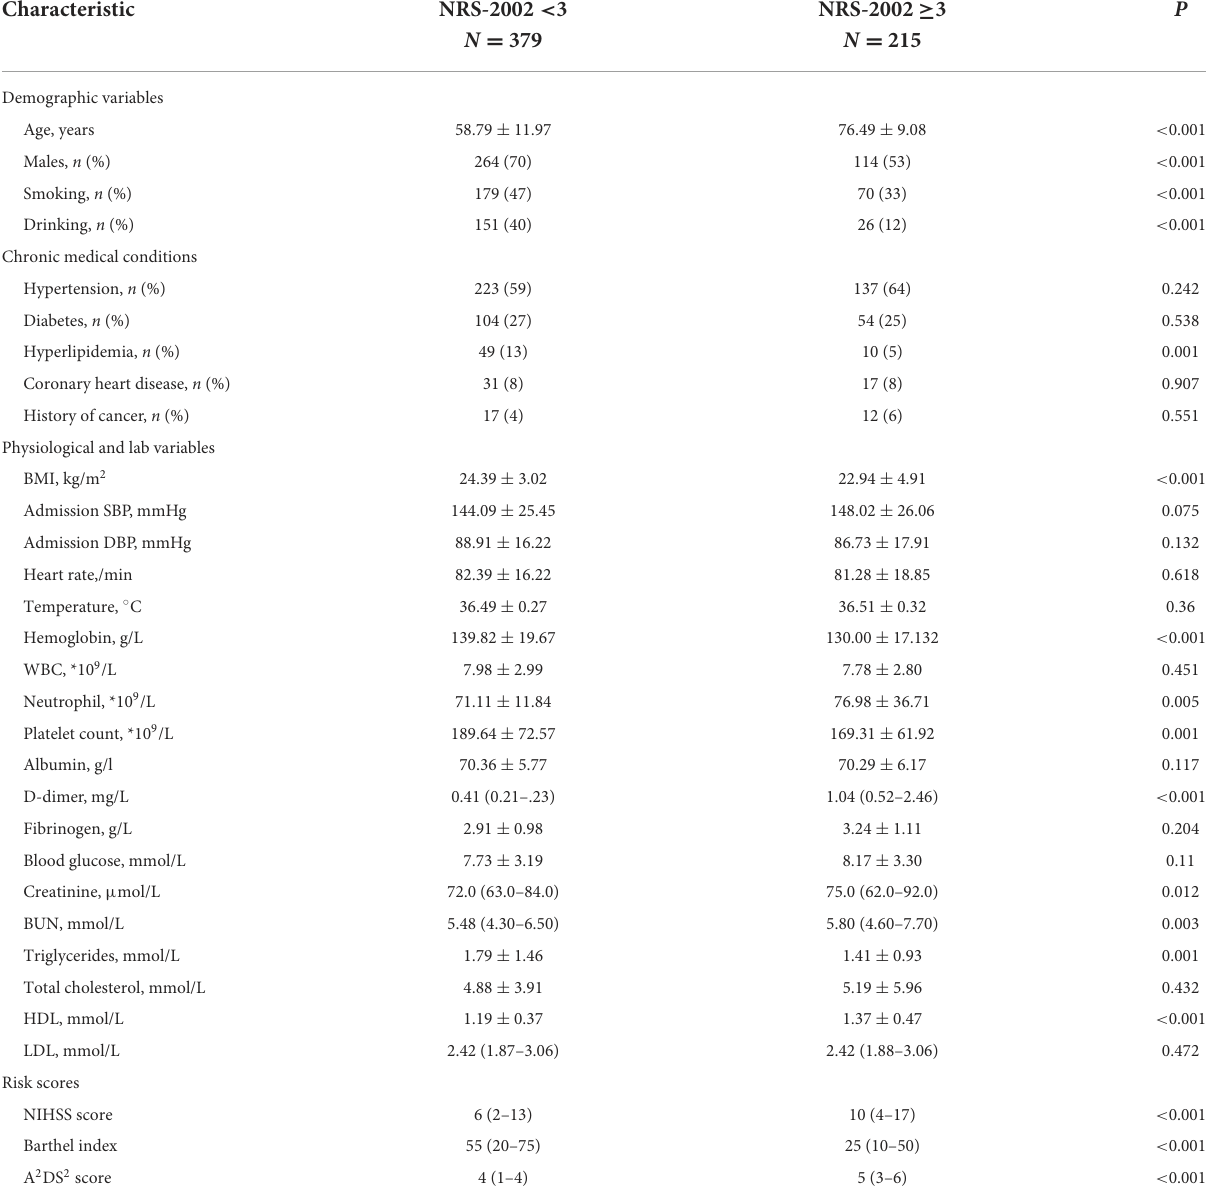
TABLE 1 Baseline patient characteristics and nutritional risk score 2002 in patients with ischemic stroke.